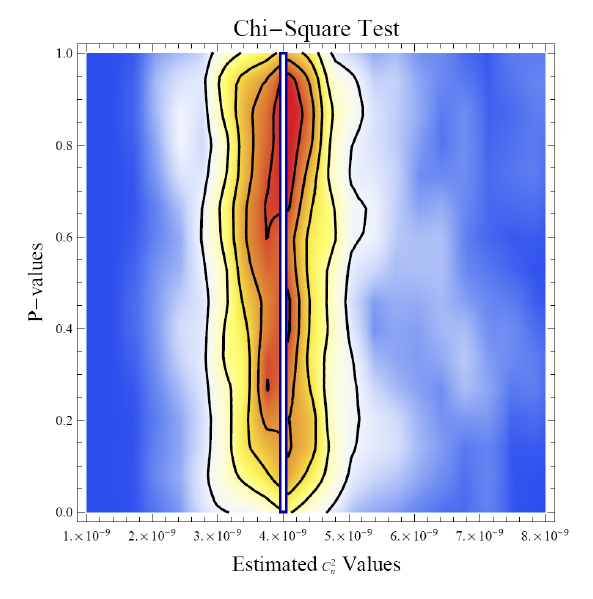
Fig. 11. Probability values as a function of C 2 η 1η estimates: Chi- squared test.